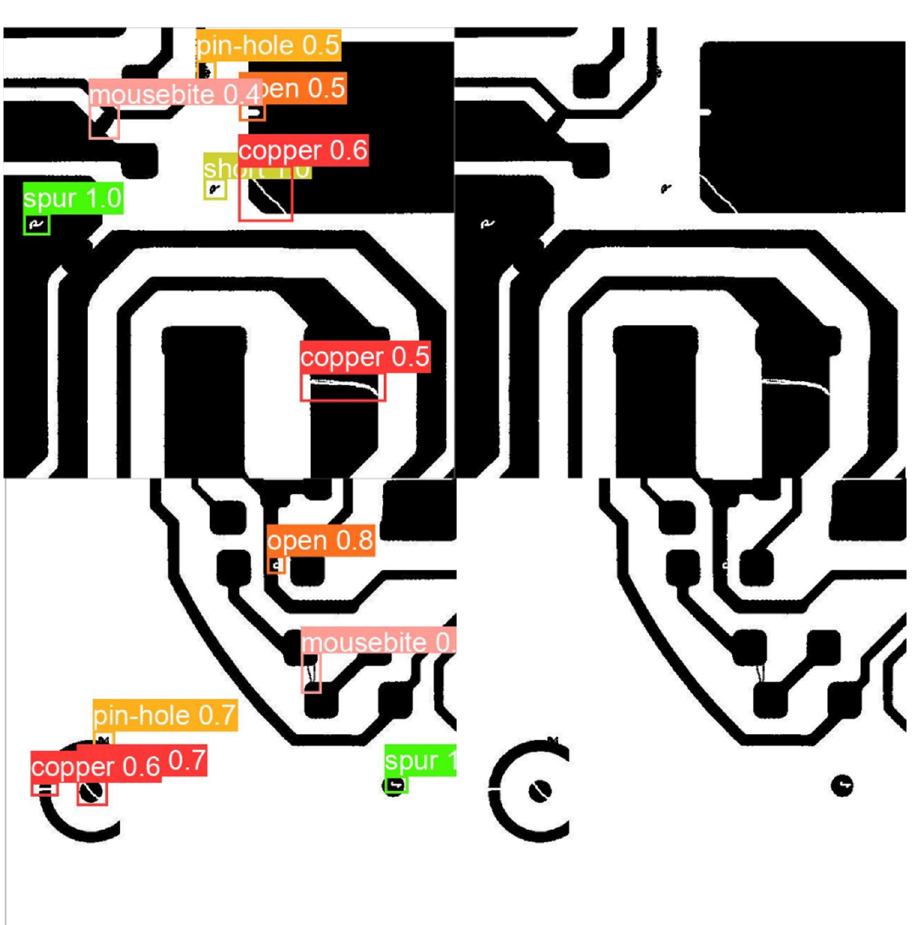
Figure 8. D etection results of proposed DE-SSD method. Figure 8. Detection results of proposed DE-SSD